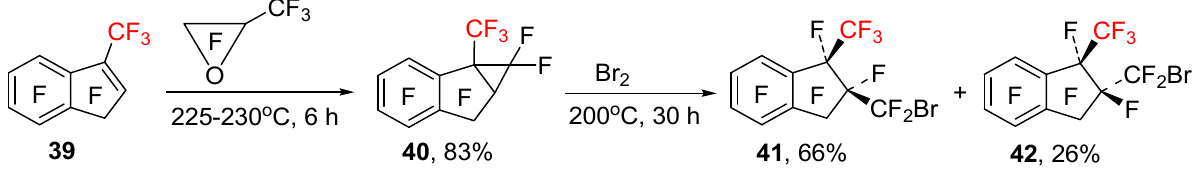
Scheme 25. Stereoselective synthesis of 1-CF 3 -indane 44 by intramolecular radical cyclization of compound 43 . Pozo, Fusteroet al. have used intramolecular 1,3-dipolar nitrone cycloaddition to con- struct a 1-CF 3 -indane core from compounds 45 (Scheme 26) [42]. The reaction of the alde- hyde group of substrates 45 with N -alkylhydroxylamines gives rise to the intermediate formation of the corresponding nitrones, which are spontaneously cyclized into isoxazol- idines 46 adjacent to the trifluoromethylindane fragment. It should be especially empha- sized that the regioselectivity of the cycloaddition is determined by the presence of the